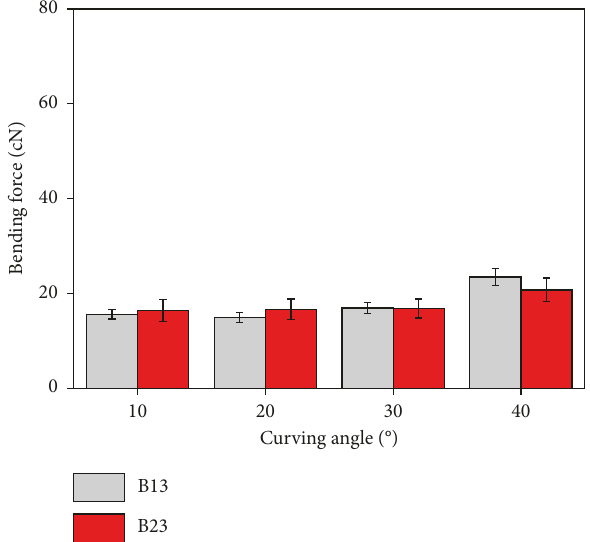
Figure 7: Bending force of stent grafts B13 and B23 given the same curving angle.